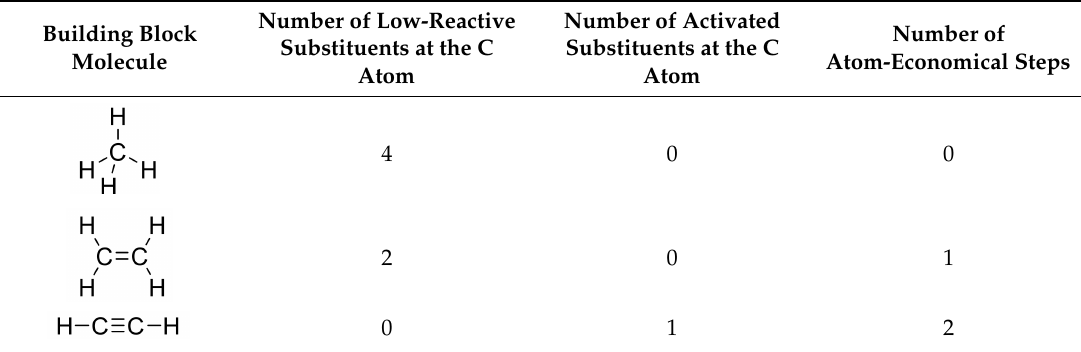
Table 4. Potential chemical building blocks for a molecular 3D printer